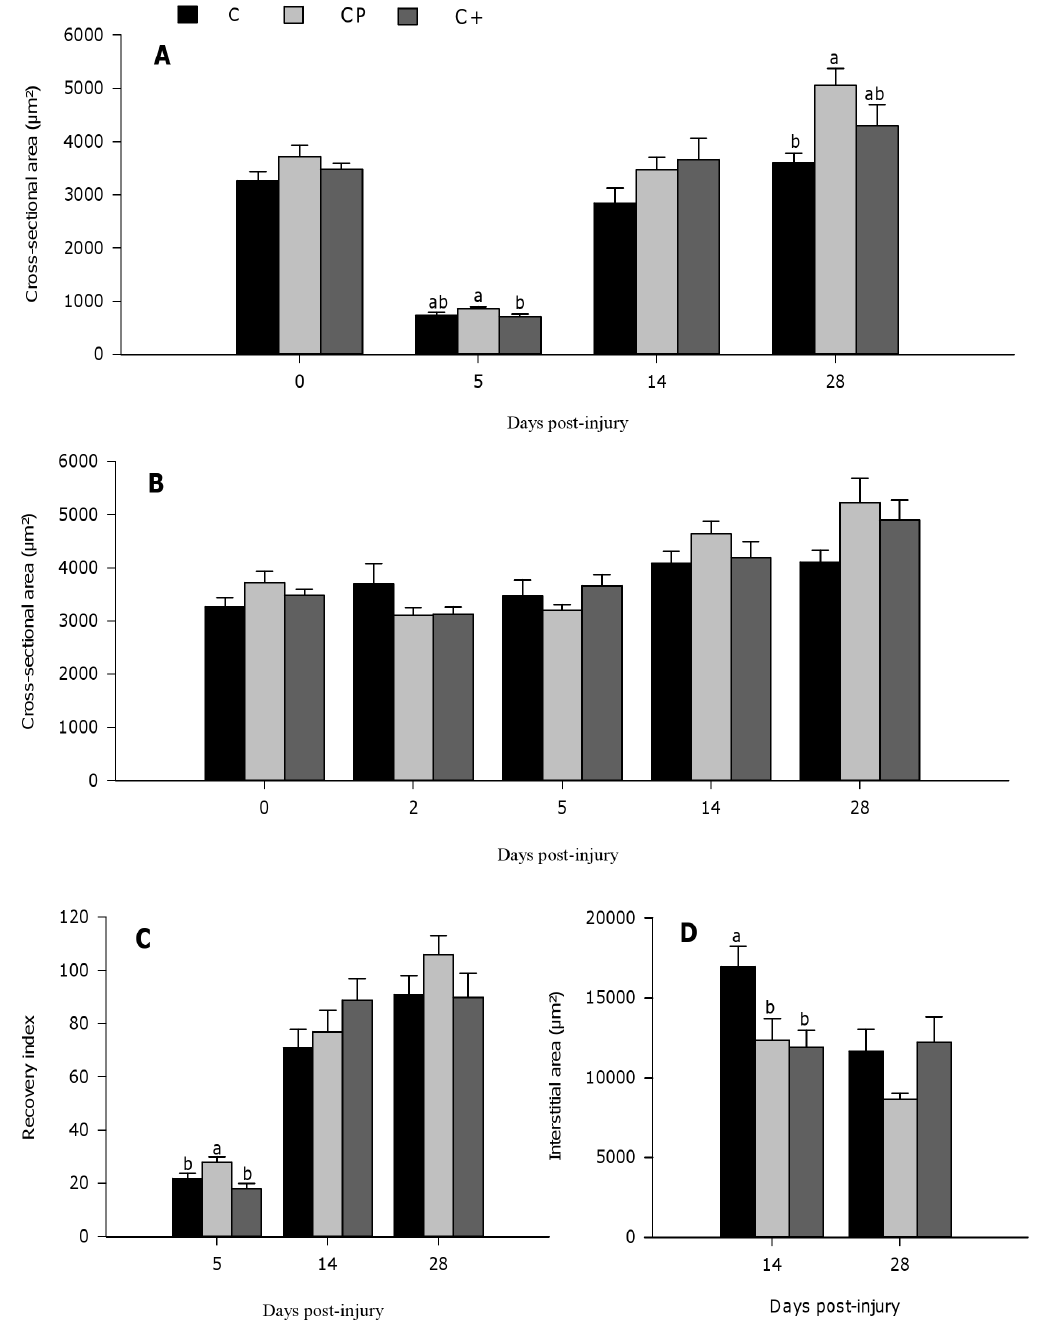
Figure 3. Muscle fiber cross-sectional area and interstitial area (µm 2 ) of regenerating tibialis anterior muscle in rat. The myofiber cross-sectional area (MCSA) was quantified at days 0, 5, 14, and 28 post-injury in three H/E-stained cryosections from injured (A) and sham (B) muscles. The MCSA was not assessed at day 2 post-injury because of massive destruction of the myofibers in the necrotic area. Two images were captured at 20X from each cryosection and the cross-sectional area of each myofiber was traced using ImageJ Analysis Sotfware Program. A recovery index was calculated by dividing the mean MCSA for the injured muscle to the corresponding sham value (C). The total cross-sectional area (TCSA) was then traced in the injured muscle, and the interstitial area was quantified by subtracting the sum of individual MCSA to the TCSA at days 14 and 28 post-injury (D). Values are mean ± SEM (n = 7-8 rats per dietary group/time point). Groups bearing different letters for a given time point are significantly different (p≤0.05). C, casein; CP, cod protein; C + , casein supplemented with L-arginine, glycine, L-taurine and L-lysine. doi: 10.1371/journal.pone.0077274.g003 PLOS ONE |